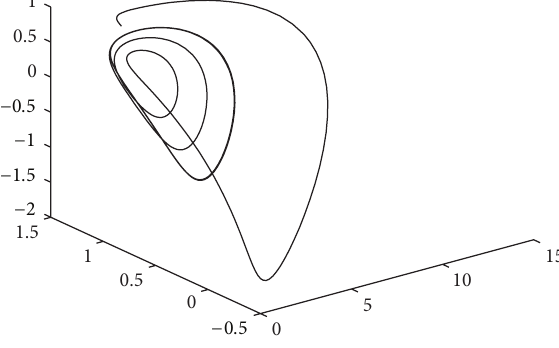
Figure 2: Simulation of system